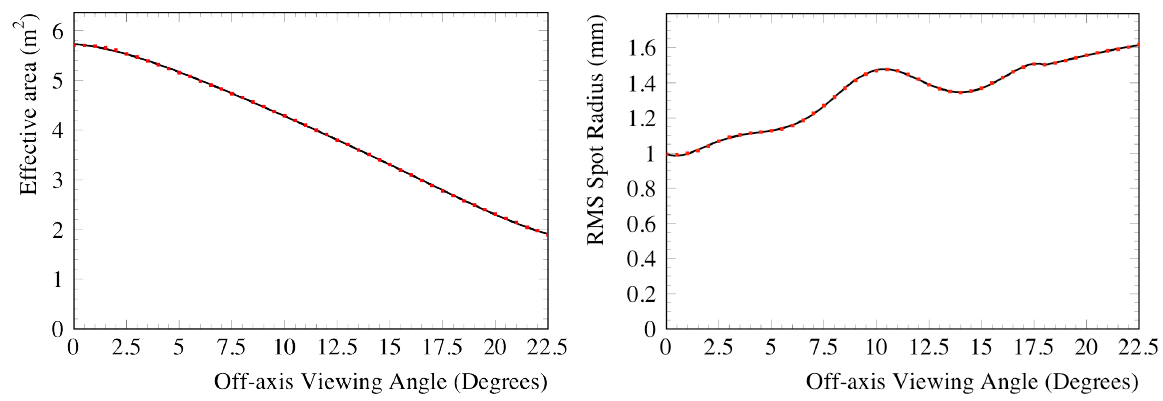
Figure 3. The e ff ective optical collecting area as a function of viewing angle for a POEMMA Schmidt telescope (left) and the rms radius of the UV PSF as a function of viewing angle (right)